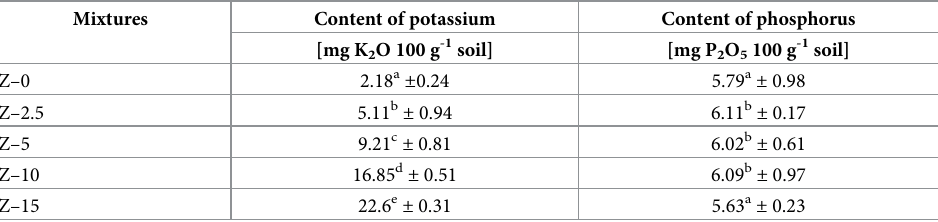
Table 6. Available potassium and phosphorus in soil and the mixtures (average value ± standard deviation).